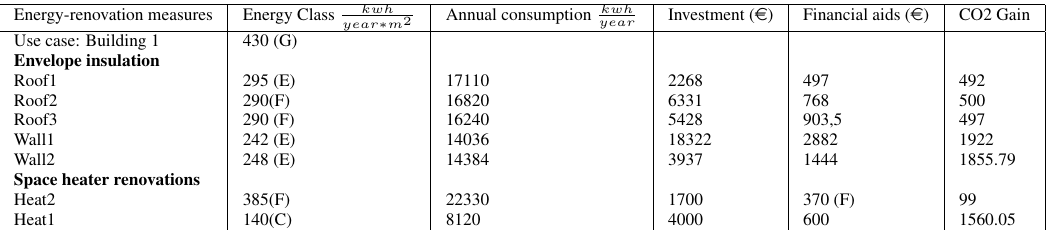
Table 4. Influence of single energy renovation measures